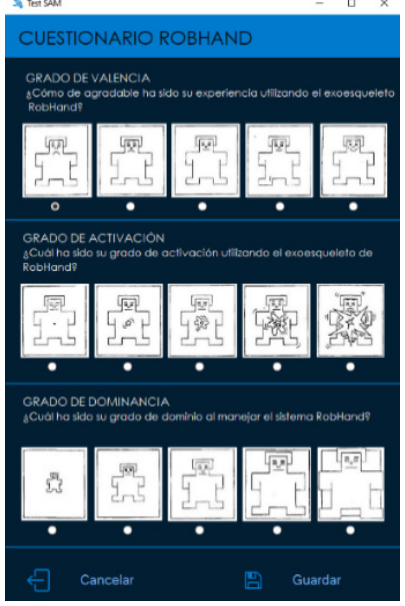
Figure 5. Computer-based SAM test.